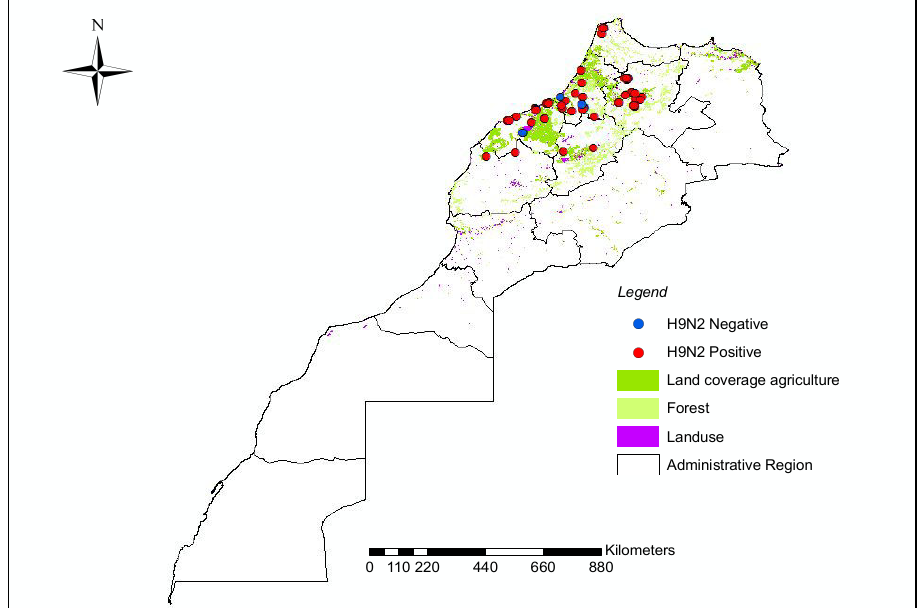
Figure 1. Location of the sampled and positive